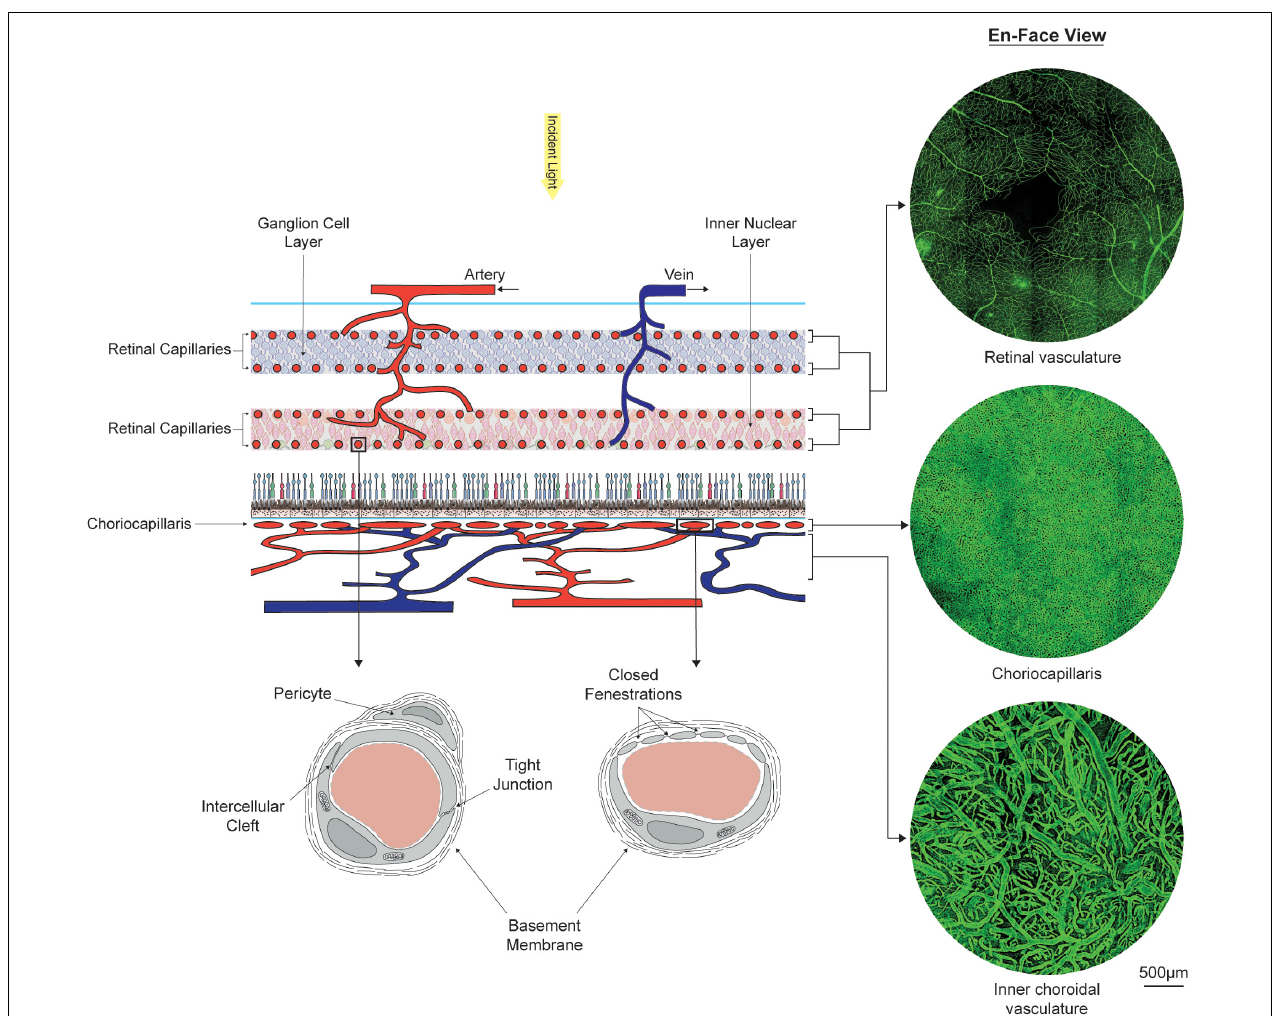
FIGURE 2 | Organization, morphology, and ultrastructure of the dual circulatory systems of the retina formed by the retinal and choroidal vasculatures. The inner two-thirds of the retina is sustained by at least four layers of retinal capillaries, which connect alternating arterial and venous branches. Oxygen and nutrients are supplied to the outer one third of the retina by the choriocapillaris, located externally to the retinal pigment epithelium. En-face visualizations of the retinal and choroidal vasculatures at the fovea were obtained by immunostaining portions of retinas and choroid with Ulex Europaeus Agglutinin and imaging them using confocal microscopy. Stark differences in vascular density between the choriocapillaris and the retinal capillary bed can be observed. Ultrastructural differences are also present. Retinal capillaries form a tightly regulated barrier between blood and tissue. Capillaries from the choriocapillaris present with closed fenestrations, which facilitate the transfer of small and large